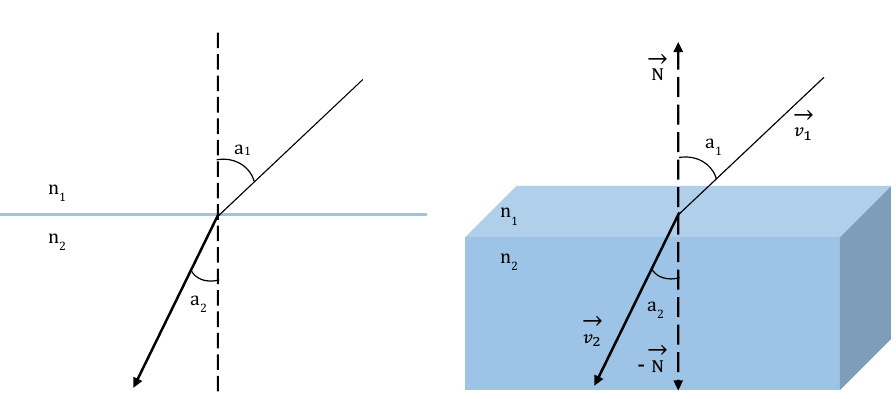
Figure 3. Snell’s law in standard form ( left ) and three ‐ dimensional vector format ( right ).